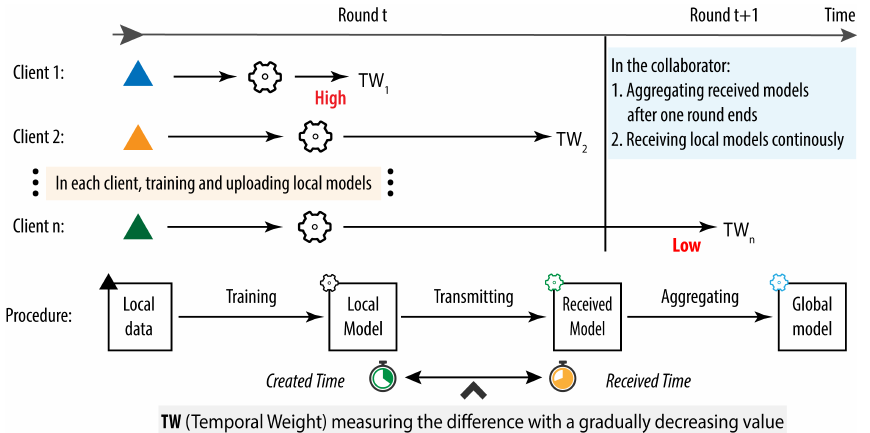
Figure 2. The schematic diagram of